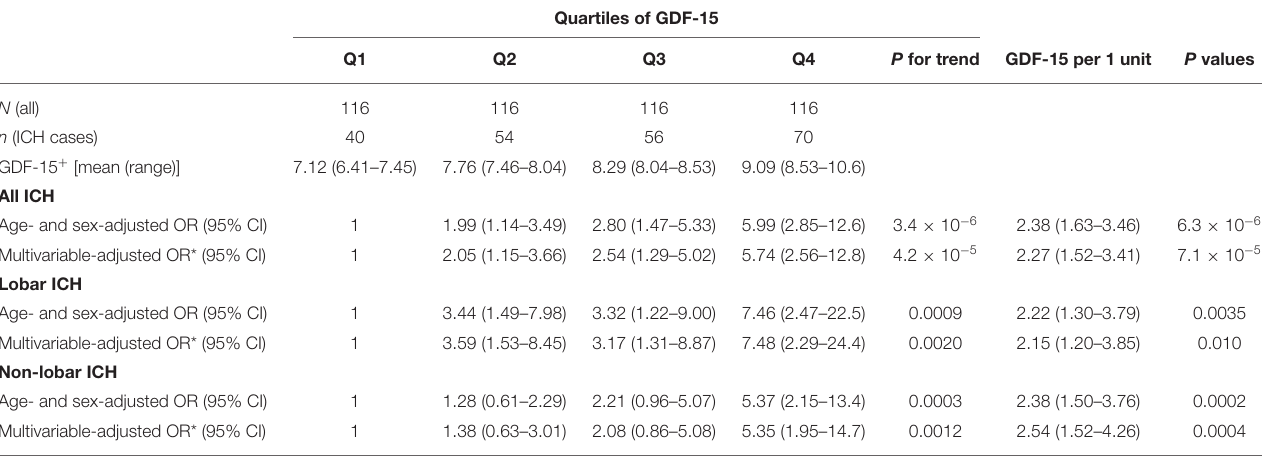
TABLE 3 | Association between GDF-15 and risk of ICH and ICH subtypes.